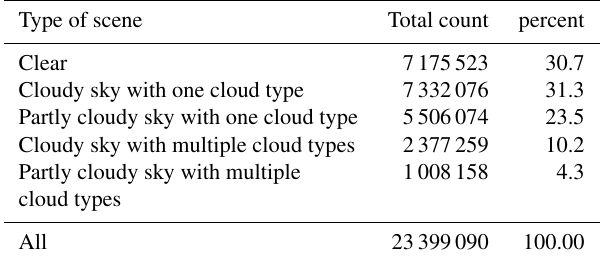
Table 2. Total counts and relative percentages of five cloud scene categories at the AIRS FOV scale: clear sky, cloudy sky with one cloud type, partly cloudy sky with one cloud type, cloudy sky with multiple cloud types, and partly cloudy sky with multiple cloud